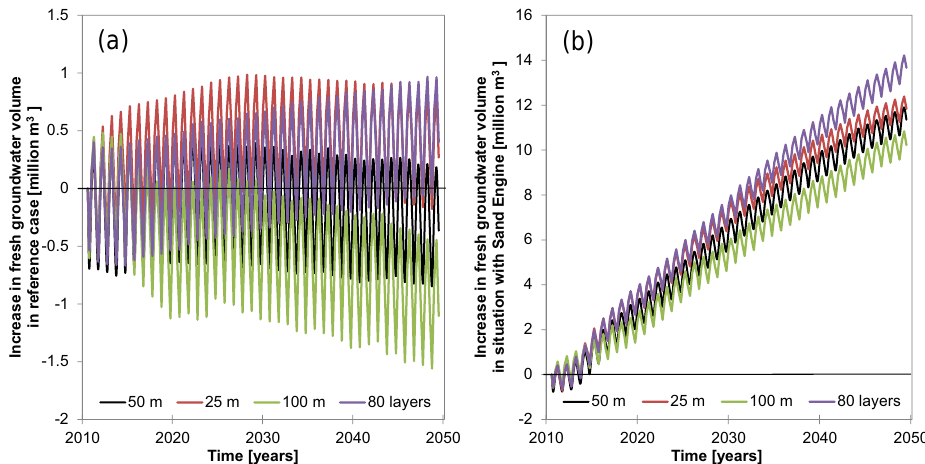
Figure A1. Increase of the volume of fresh groundwater in the situation without Sand Engine (a) and situation with Sand Engine (b) in the period 2011 to 2050, where the legend refers to the four grid discretization simulations.